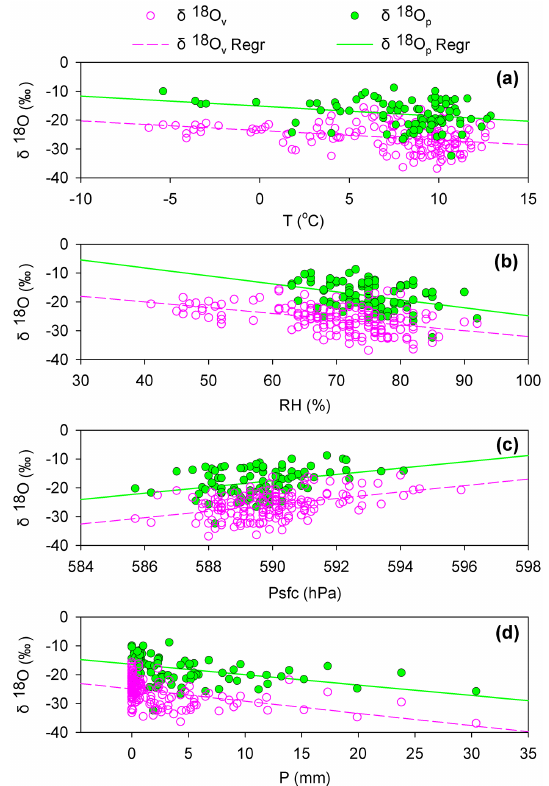
Figure 4. Relationships between δ 18 O and meteorological factors ( a , temperature; b , relative humidity; c , surface pressure; and d , precipitation amount) at Nagqu. Note that the values of δ 18 O v are shown as pink open circles; the values of δ 18 O p are shown as green solid dots.